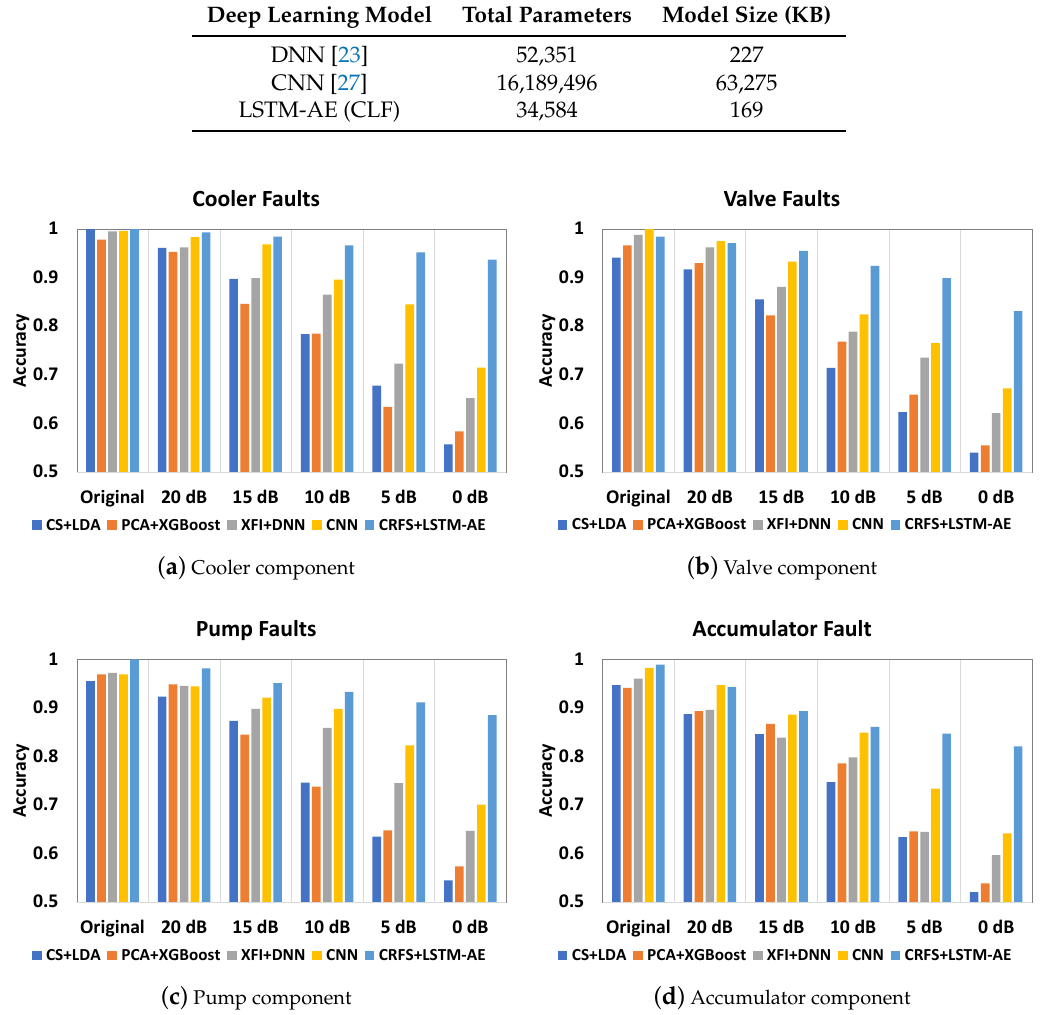
Figure 10. Experiments on fault detection with multiple algorithms spanning a range of noise